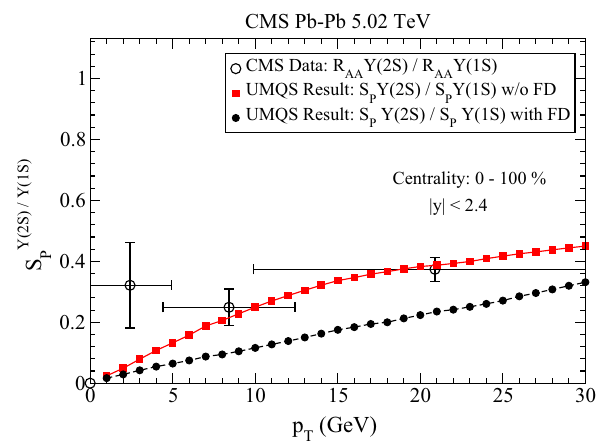
Fig. 10 The predicted yield ratio of ϒ( 2 S ) to ϒ( 1 S ) is compared with the observed double ratio, ϒ( 2 S ) to ϒ( 1 S ) in Pb − Pb collision [90]